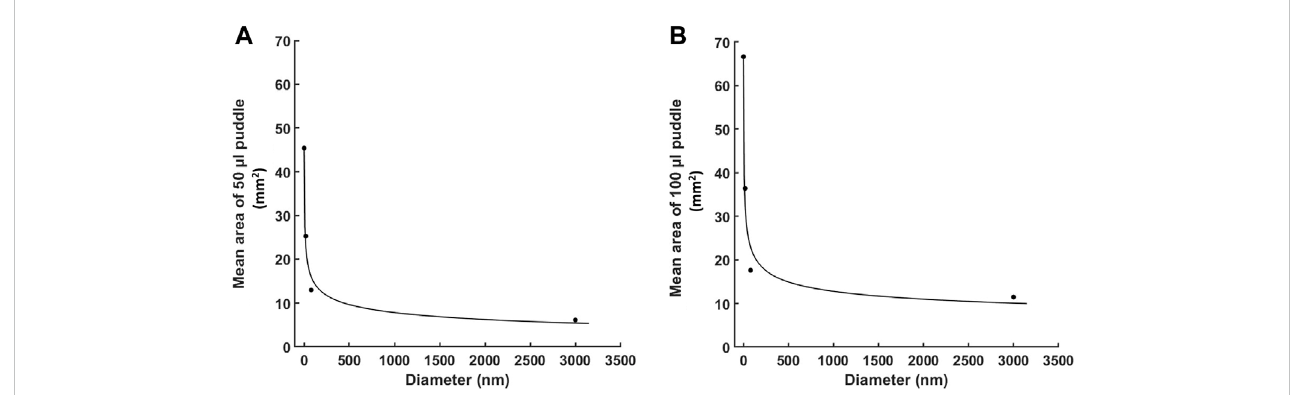
FIGURE 5 Quantitative curve fi tting for the area of the puddle with respect to the particle ’ s diameter. A two-term power law fi tting for the mean area of the puddle for: (A) 50 µL injections, and (B) 100 µL injections. Each dotted point represents the mean puddle area for one of the four molecules (n = 6 each). Fitting is generated by MATLAB.